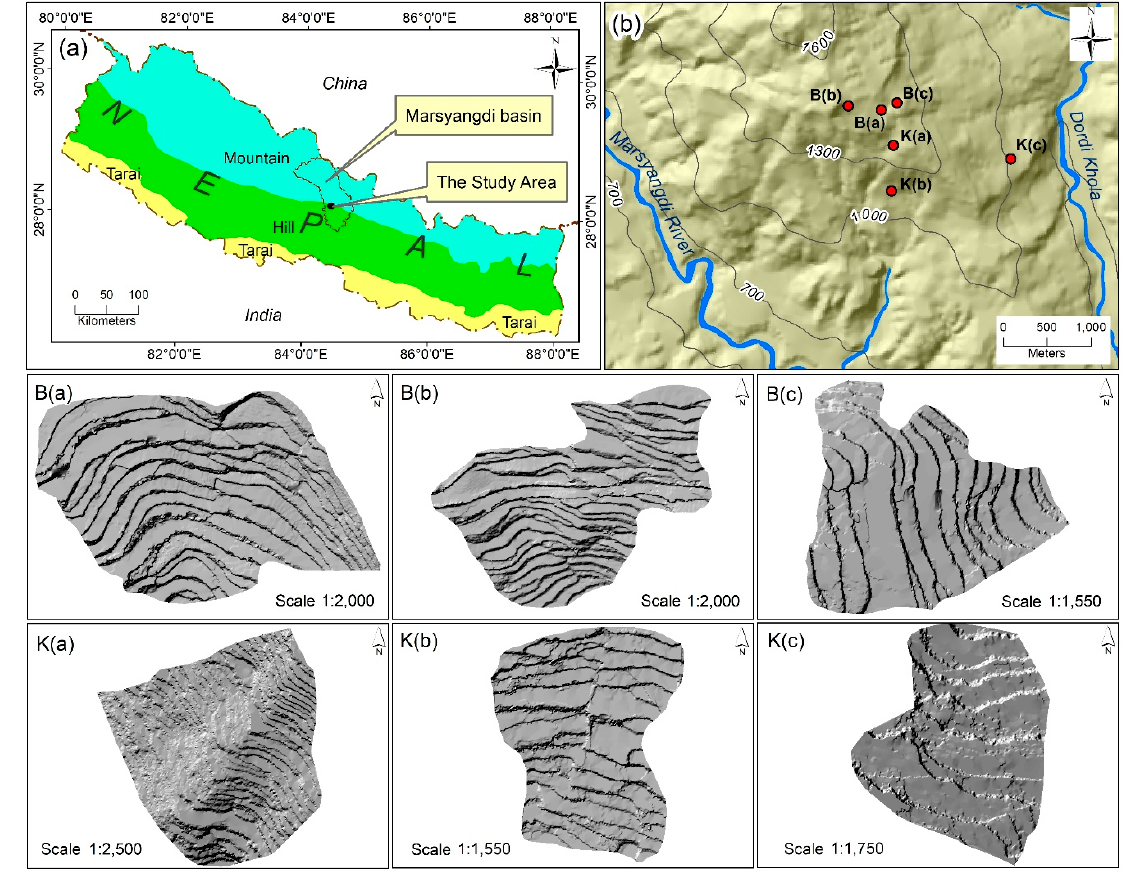
Figure 1. Location of the study area ( a ), plots location ( b ), and the selected six plots. Farmers manage their cultivated land by making complete horizontal terraces at irrigated plots and outward sloping terraces for rain-fed plots. They grow grasses and fodder trees at terrace riser. Intensive subsistence farming practice is evident in the area as intensive use of cultivated land, which integrates livestock, forest, and grasses in their system of livelihood. As shown in Figure 1, six plots were selected as the study areas. Among them, three were rain-fed and three were irrigated agriculture plots. In local term, a rain-fed cultivated terrace is known as bari, and an irrigated terrace is known as khet. Therefore, the selected rain-fed plots were named B(a), B(b), and B(c) plots, and the irrigated plots were named K(a), K(b), and K(c) plots. The total area of the selected plots was 3.22 hectares. The area of the smallest plot was 0.26 hectares, and the largest one